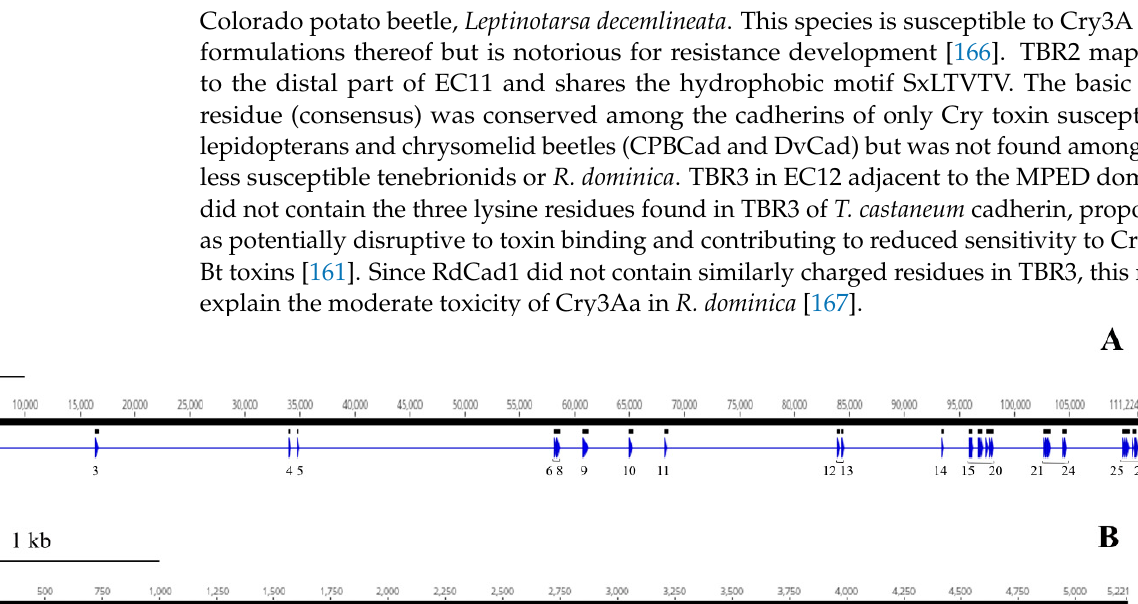
Figure 10. Genomic and domain organization of the putative Bt-R1-like cadherin of R. dominica . ( A ) Schematic representation of organization of the RdCad1 cadherin gene. Thin, horizontal blue line below the black solid scale indicates the genomic sequence, with the individual exons shown as blue triangles. ( B ) Schematic representation of the exons (blue rectangles) and their encoded RdCad1 functional domains EC1–12, MPED, TM, and CYT (lower). The above black, solid lines correspond to the transcript coding region and the scale, respectively. The first 5’-UTR ( − 1) and the last 3’ (29) exons are depicted in grey, as their untranslated sequence regions were not experimentally confirmed.